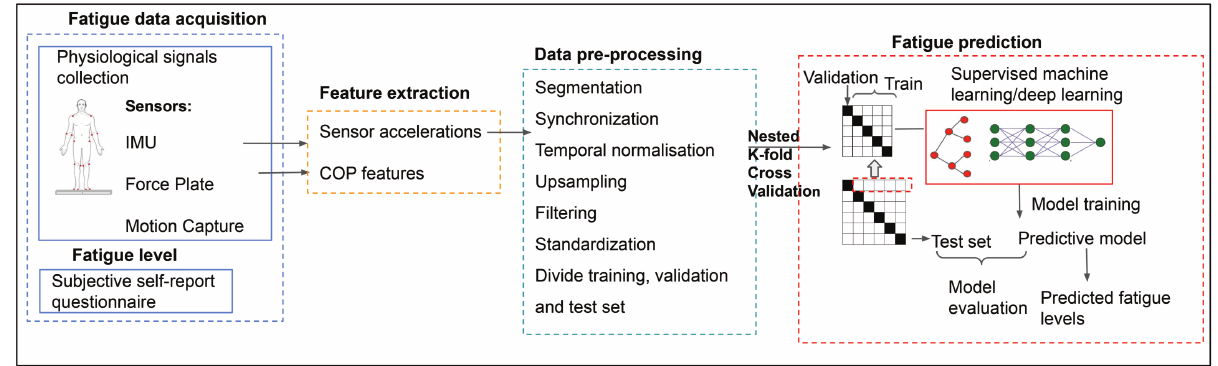
Figure 1. An overview of the proposed method. COP, center of pressure.